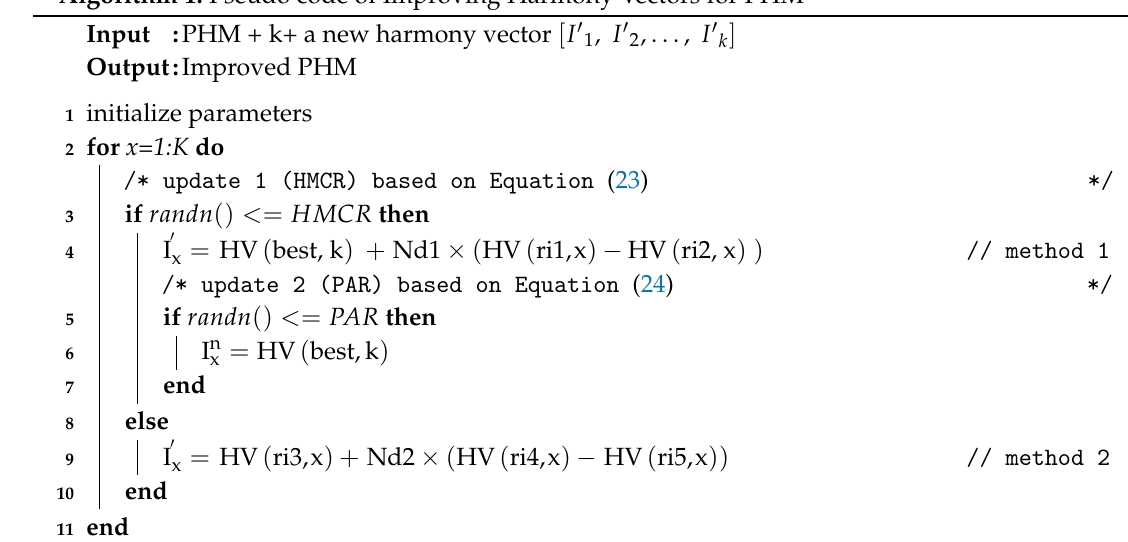
Algorithm 1: Pseudo code of Improving Harmony Vectors for